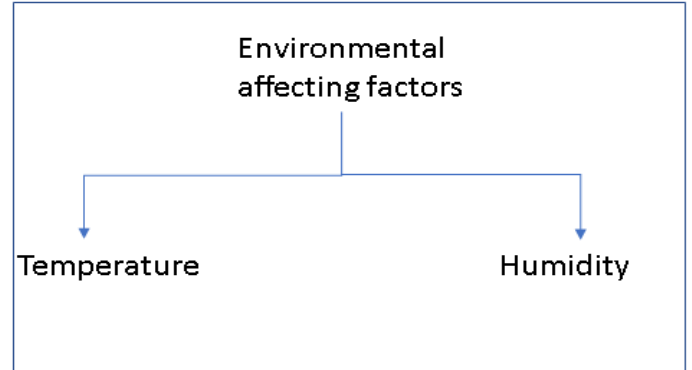
Figure 4. Environmental affecting